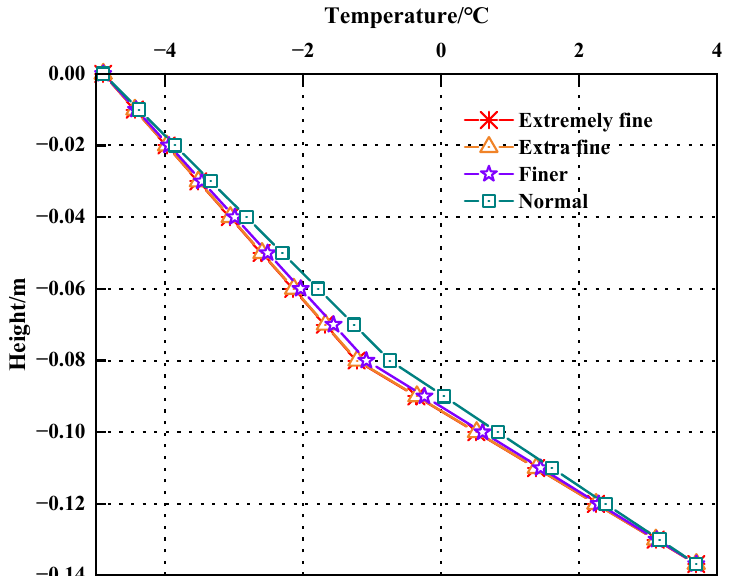
Figure 6. Calculation results under different grid numbers.